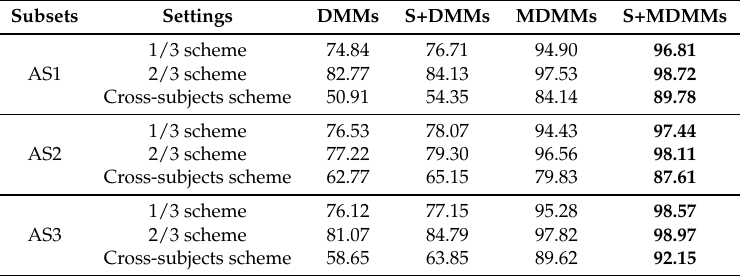
Table 9. Performance of the deep motion model based on MDMMs and DMMs concatenated with spatial information (depth) in terms of MSR 3D action dataset.